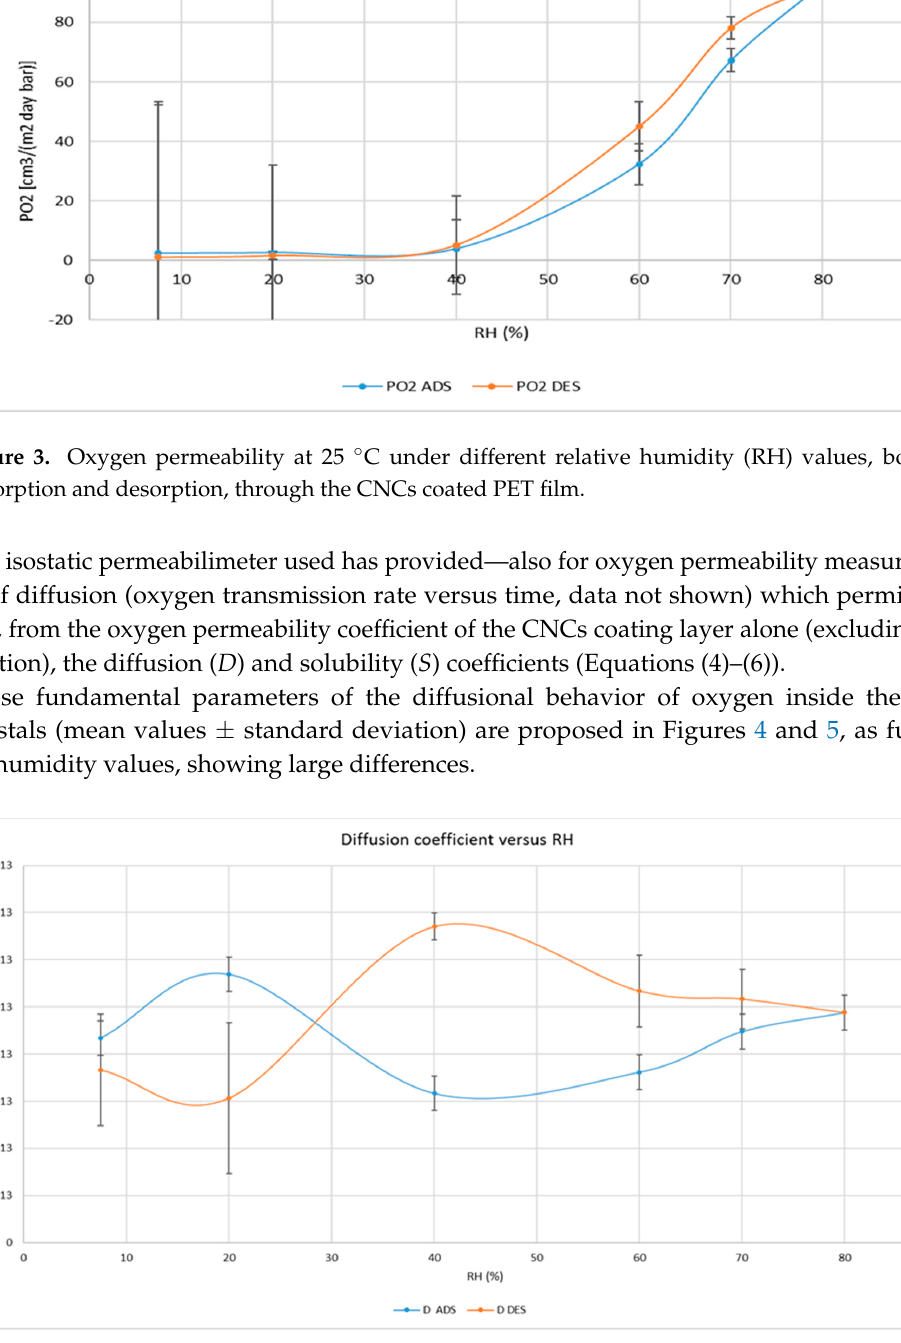
Figure 4. Oxygen diffusion coefficients under different RH values, both in adsorption and desorption, through the CNCs coated PET film.